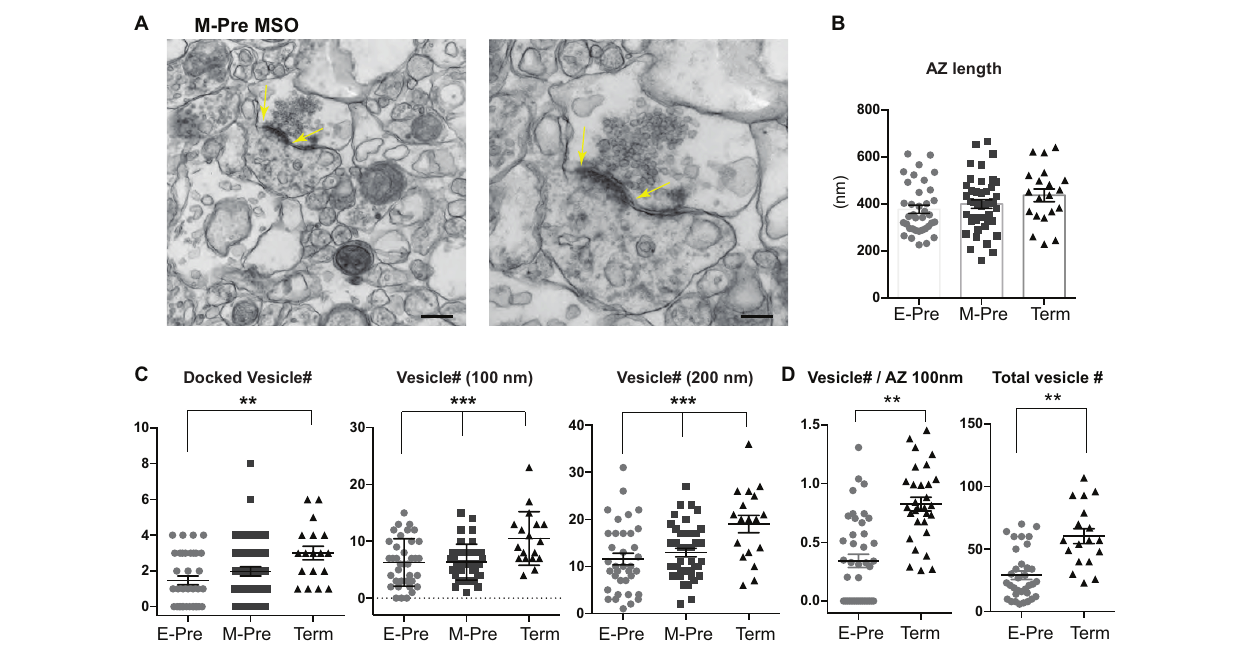
FIGURE 4 | Presynaptic terminal undergoes structural refinement during gestational development. (A) EM images of MSO synapse from M-Pre neonates. Yellow arrows indicate the active zone (AZ) at the presynaptic bouton. Scales = 400 and 200 nm. (B) AZ length at the presynaptic boutons in the MSO from E-Pre, M-Pre, and Term neonate. (C) The numbers of docked vesicles, which are located within 10 nm from the AZ, and numbers of vesicles located within 100 and 200 nm around the AZ in the presynaptic terminal. Data were shown as mean ± s.e.m. ** < 0.01 and *** < 0.001, one-way ANOVA test. (D) Numbers of docked vesicles in the defined AZ (100 nm) and numbers of total vesicles in individual boutons. Data were shown as mean ± s.e.m. ** < 0.01, unpaired t -test.